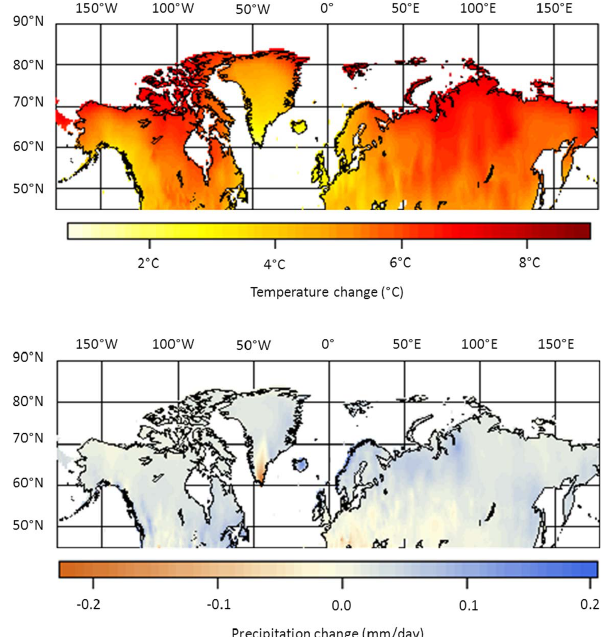
Fig. 1. (a) Temperature ( ◦ C) and (b) precipitation (mmday − 1 ) dif- ference of the annual means between the end of the 21st century and the beginning of the 20th century. The values are a mean of 19